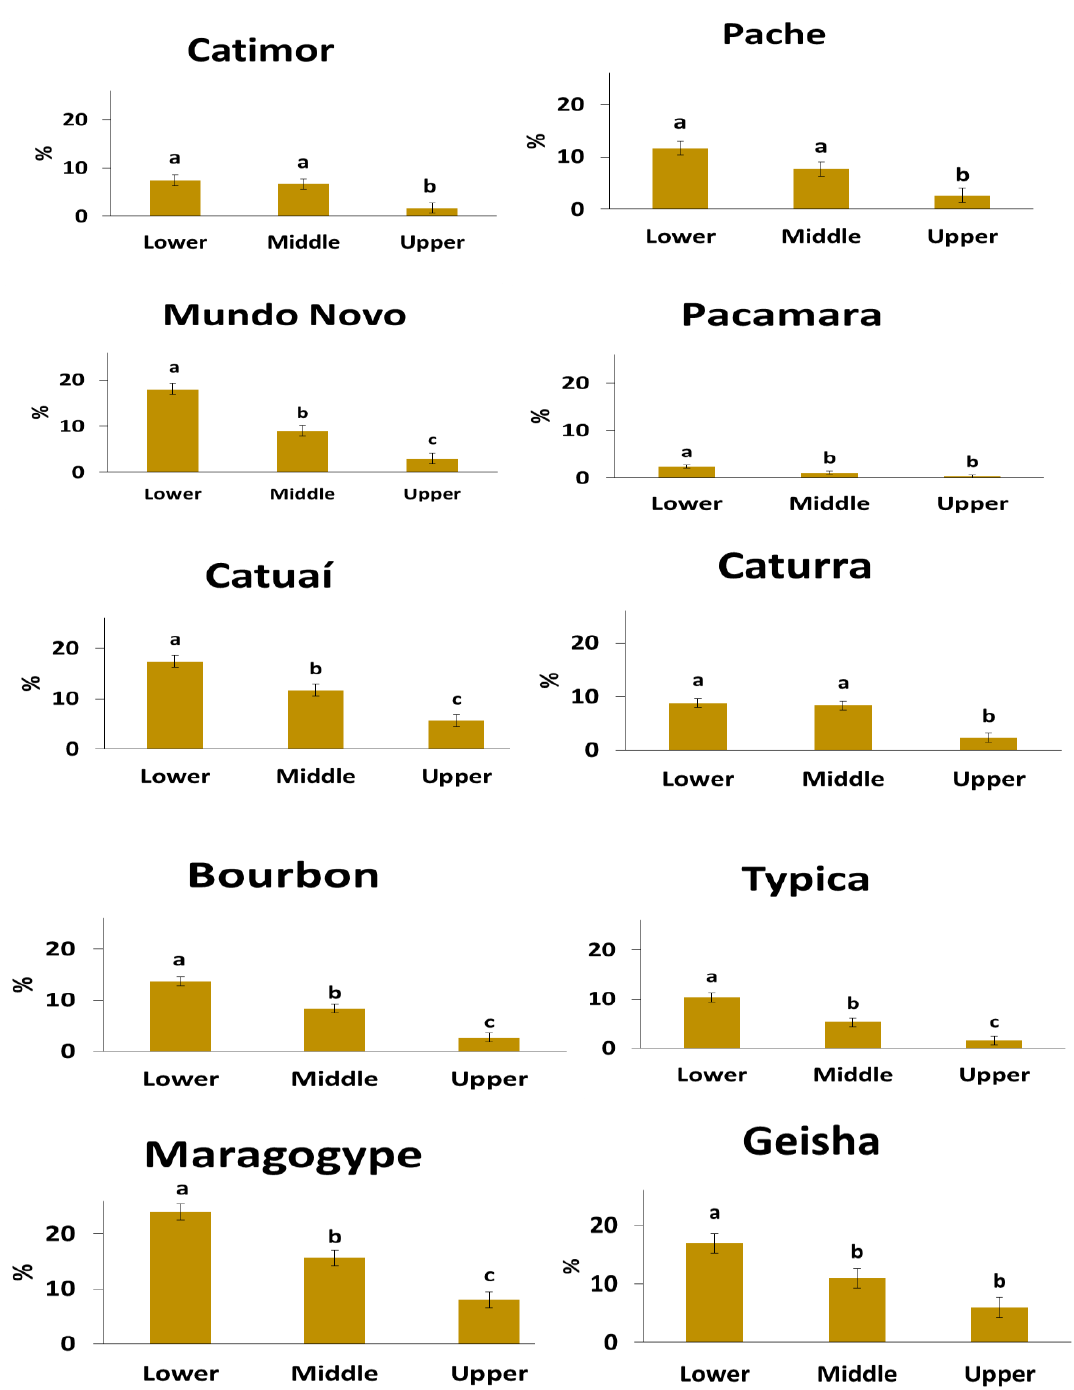
Figure 5. Coffee Leaf Rust (CLR) severity in the lower, middle, and upper sections for each cultivar. CLR severity values are the result of the April, May, and June average. Different letters indicate statistical differences according to the Scott-Knott test ( p ≤ 0.05).